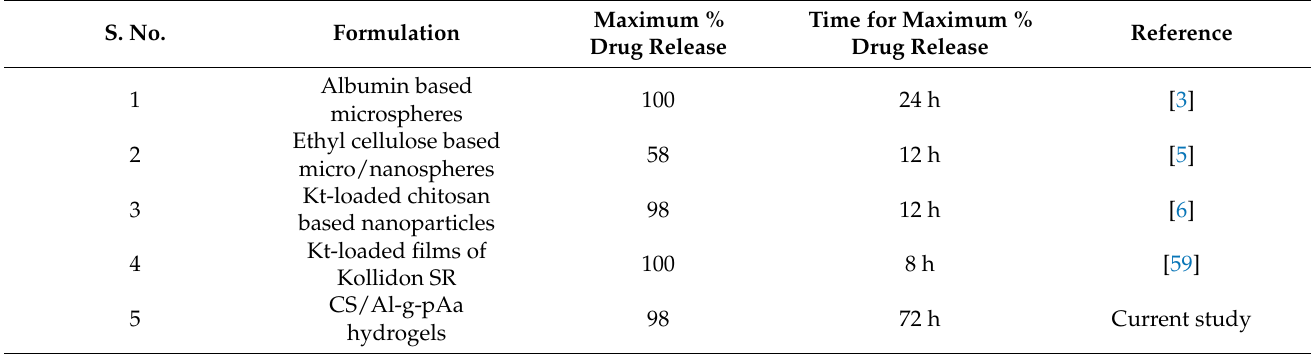
Table 5. Comparison of Kt-loaded CS/Al-g-pAa hydrogels with other Kt delivery systems. Maximum S. No. Formulation